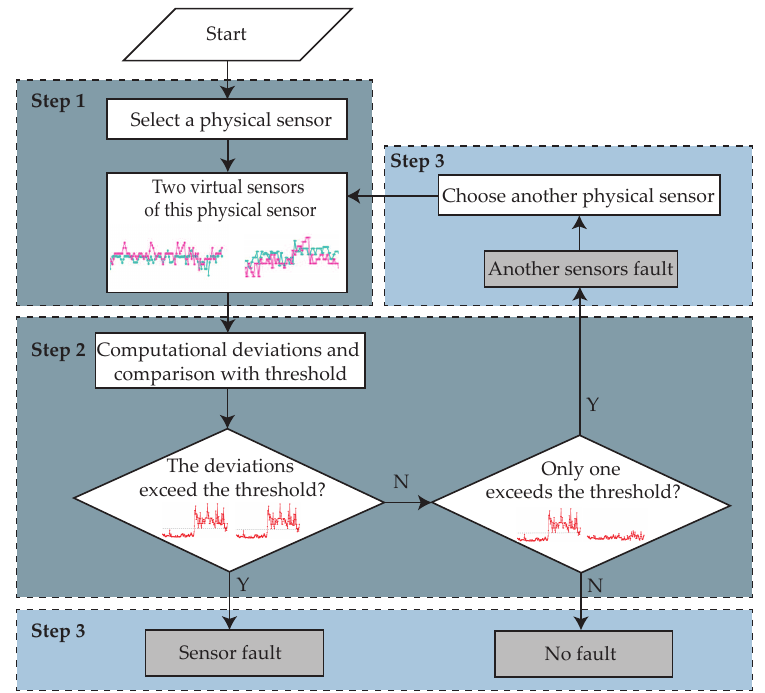
Figure 5. Flow chart of fault diagnosis.